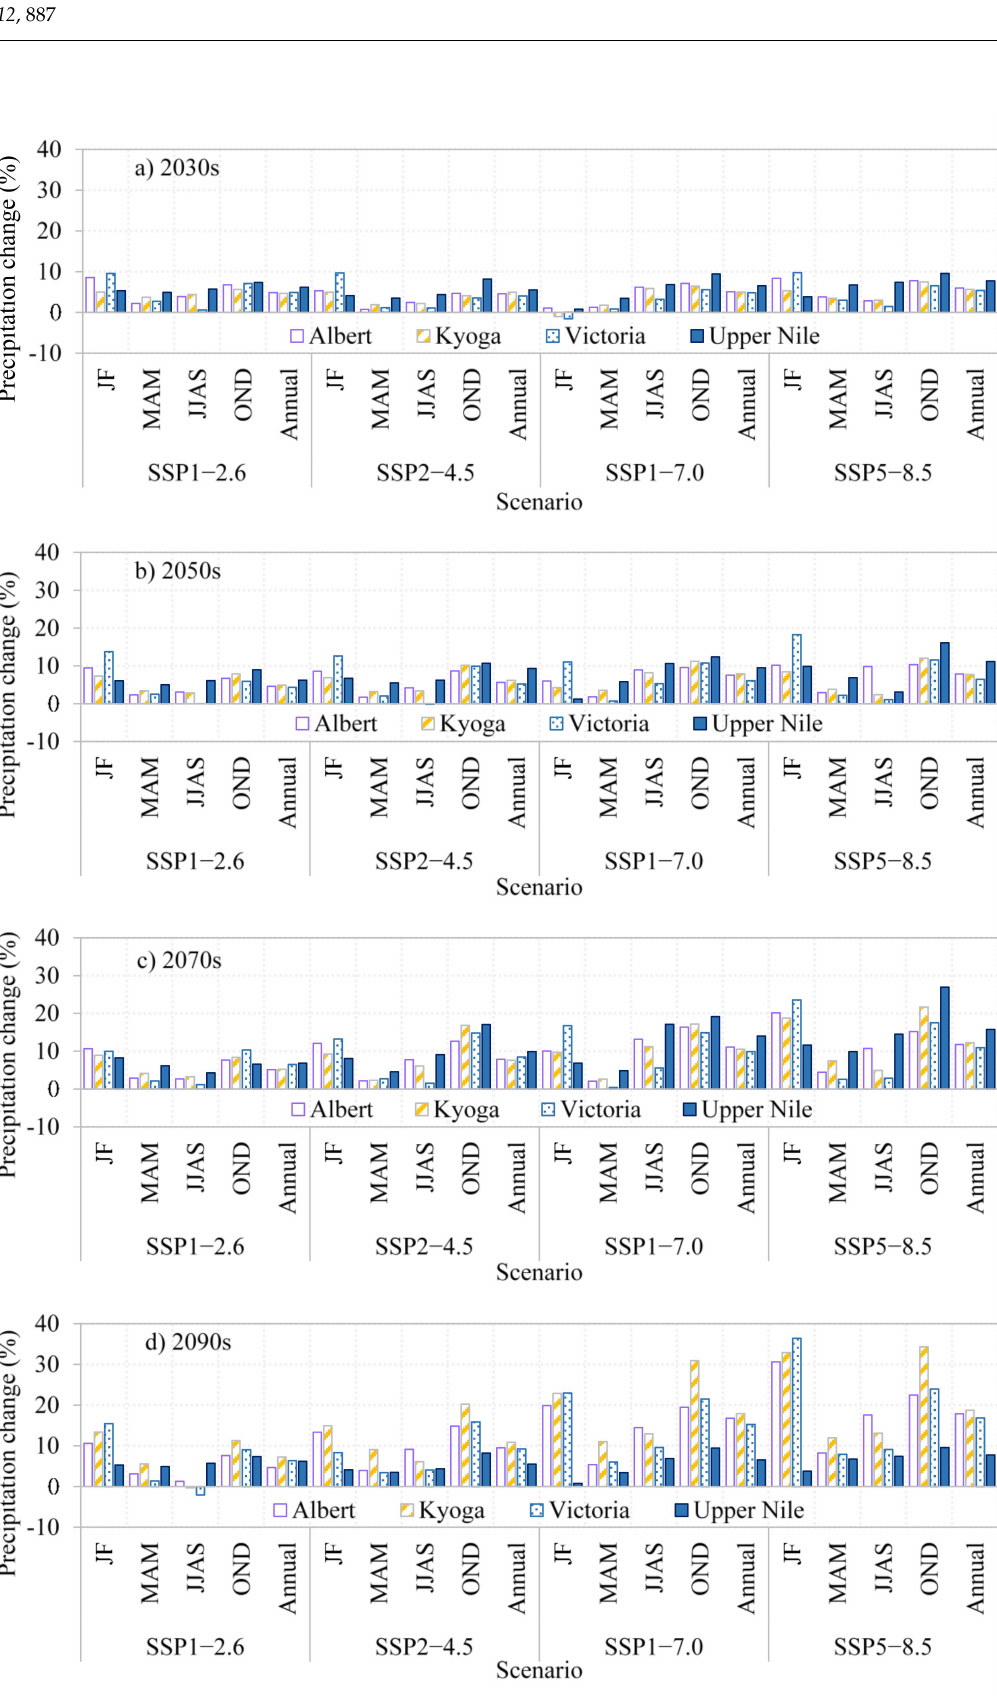
Figure 4. Projected percentage changes in precipitation averaged over each WMZ for the ( a ) 2030s, ( b ) 2050s, ( c ) 2070s, and ( d )